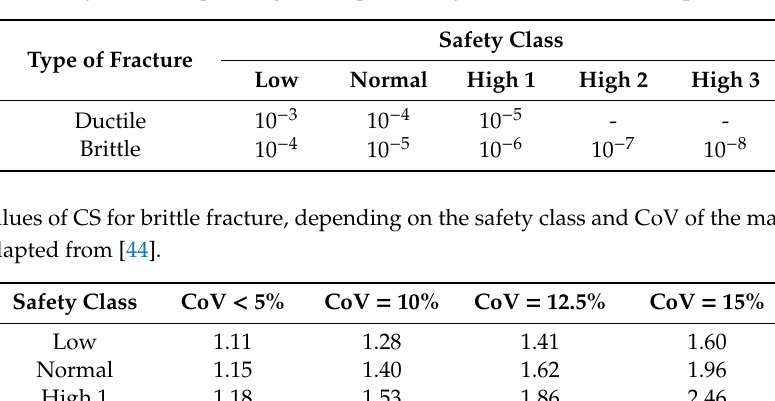
Table 7. Safety classes depending on the probability of annual failure, adapted from [44].